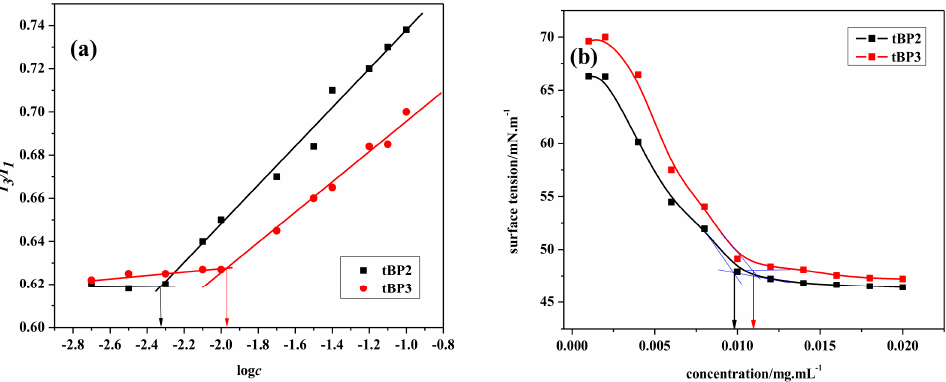
Figure 3 . The CMC of the triblock copolymer tBP2 and tBP3 as determined by the emission spectra ( a ) or automatic surface tension meter ( b